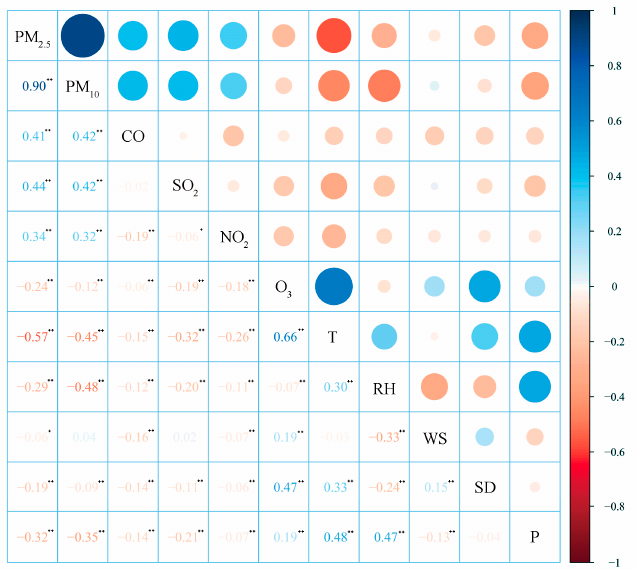
Figure 8. Correlation coefficients among meteorological factors and atmospheric pollutants. (T: tem ‐ perature, RH: relative humidity, WS: wind speed, SD: sunshine duration, and P: precipitation. ** Indicates that the correlation is significant at the level of 0.01, and * indicates that the correlation is significant at the level of